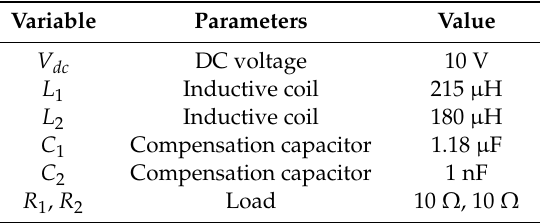
Table 3. Simulation and experimental